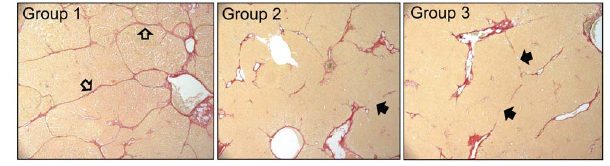
Figure 2. Representative histology of Sirius red stained liver sections from experiment described in Figure 1. A photomicro- graph was chosen from each experimental group that was approxi- mately equal to the mean of the group for percent area stained with Sirius red. Open arrows=strands of bridging fibrosis; Closed arrow- s=incomplete (broken) strands of bridging fibrosis.